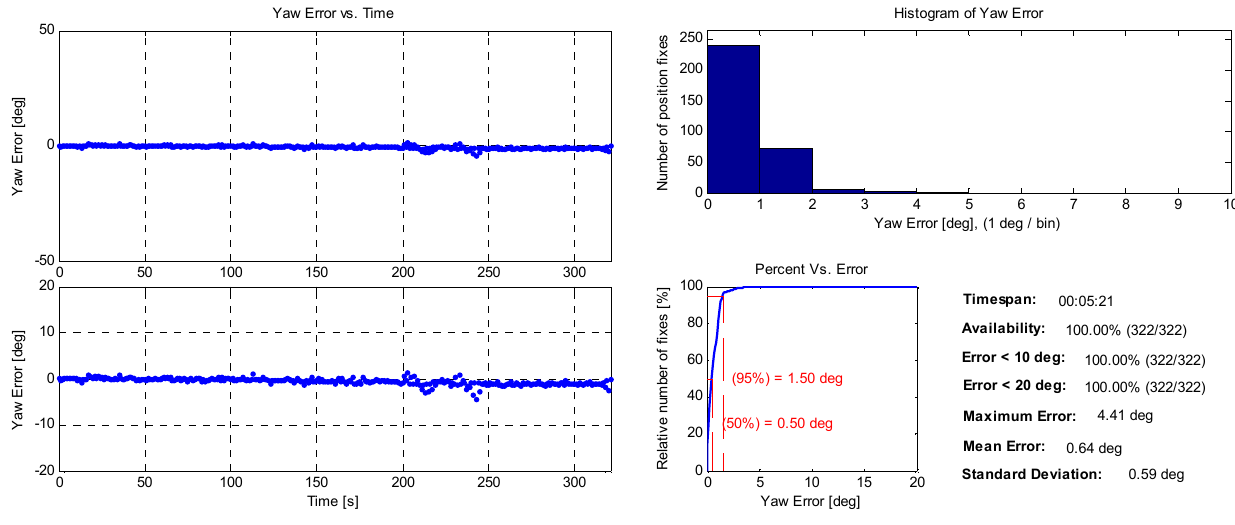
Figure 10. Yaw angle error statistics of the camera/IMU/GNSS